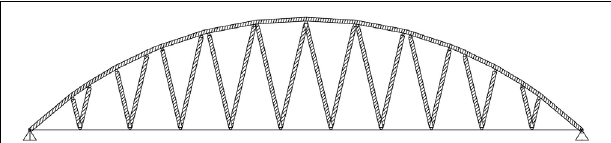
FIGURE 2 | Virtual bridge configuration V0 showing fictitiously stiffened stays and arch.